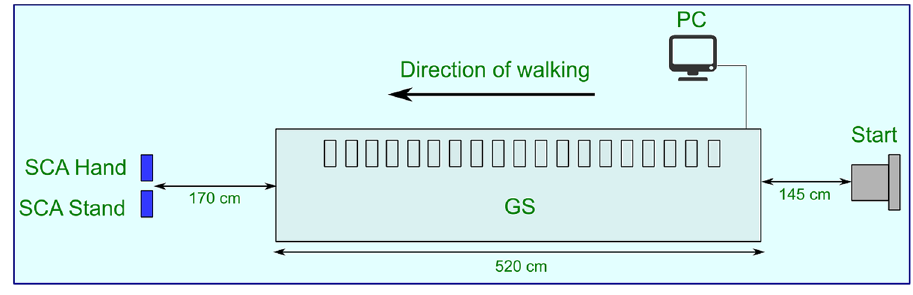
Figure 5. Assessment